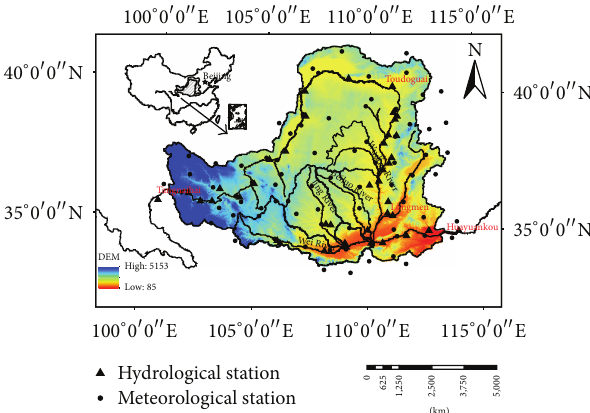
Figure 1: Sketch map and DEM of the study area (Loess Plateau) (triangle, hydrological gauged stations; rectangle, meteorological